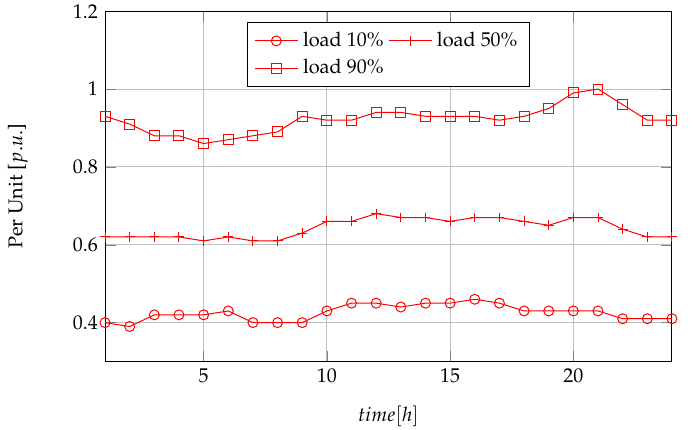
Figure 4. Example of normalized electrical load probabilistic